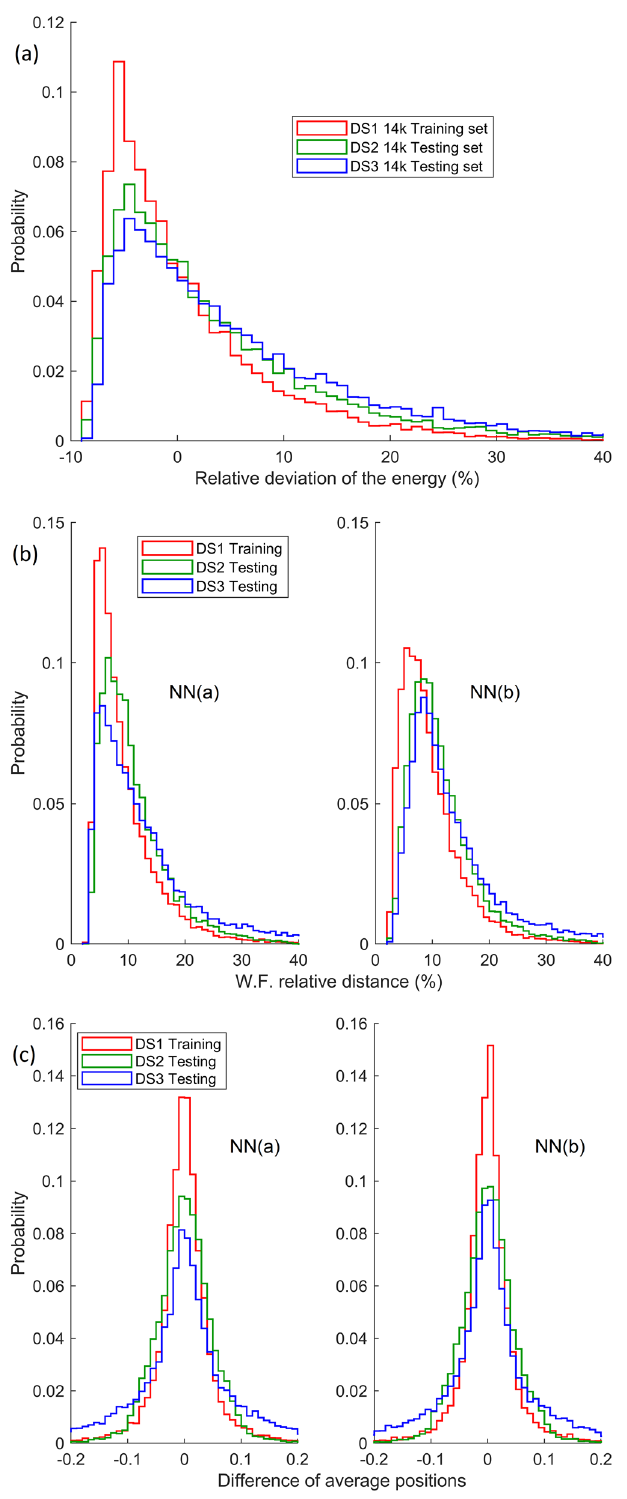
Figure 5. Multiple histograms comparing the NNs predictions for the 14 k samples in each of the testing DS2 and DS3 and the estimations for the 14 k samples in the training DS1: ( a ) relative deviation of energies; ( b ) relative “distance” between wave functions; ( c ) accuracy of average positions. The underlying shapes of the probability distributions are indicated by the histogram external